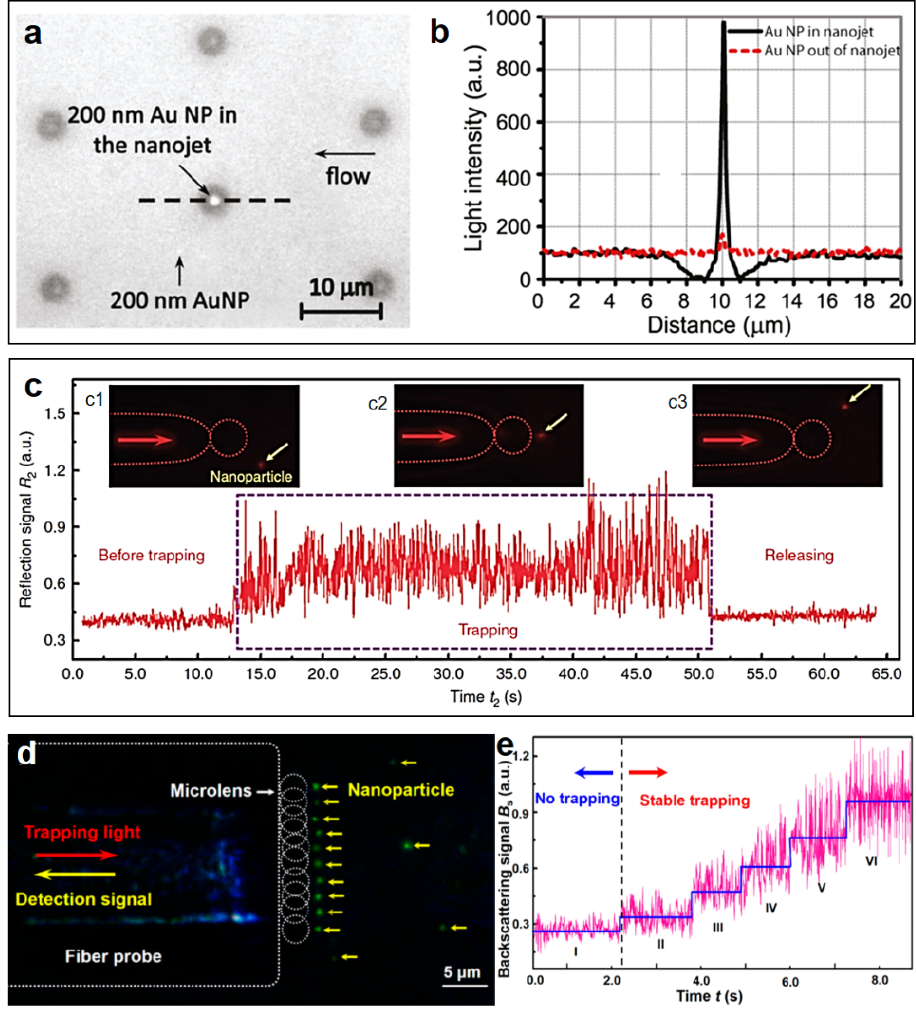
Figure 5. Backscattering signal enhancement of microlenses. ( a ) Two hundred nanometer diameter Au nanoparticles on a photonic nanojet; ( b ) Fluorescent image of UCNP solution with fiber probe without ( Ι ) and with (II) biological microlens; ( c ) Optical trapping of fluorescent nanoparticles by TiO 2 microlenses; ( d ) Optical images of fluorescent nanoparticles trapped by a microlens array; ( e ) Backscattering signals during trapping of multiple nanoparticles.